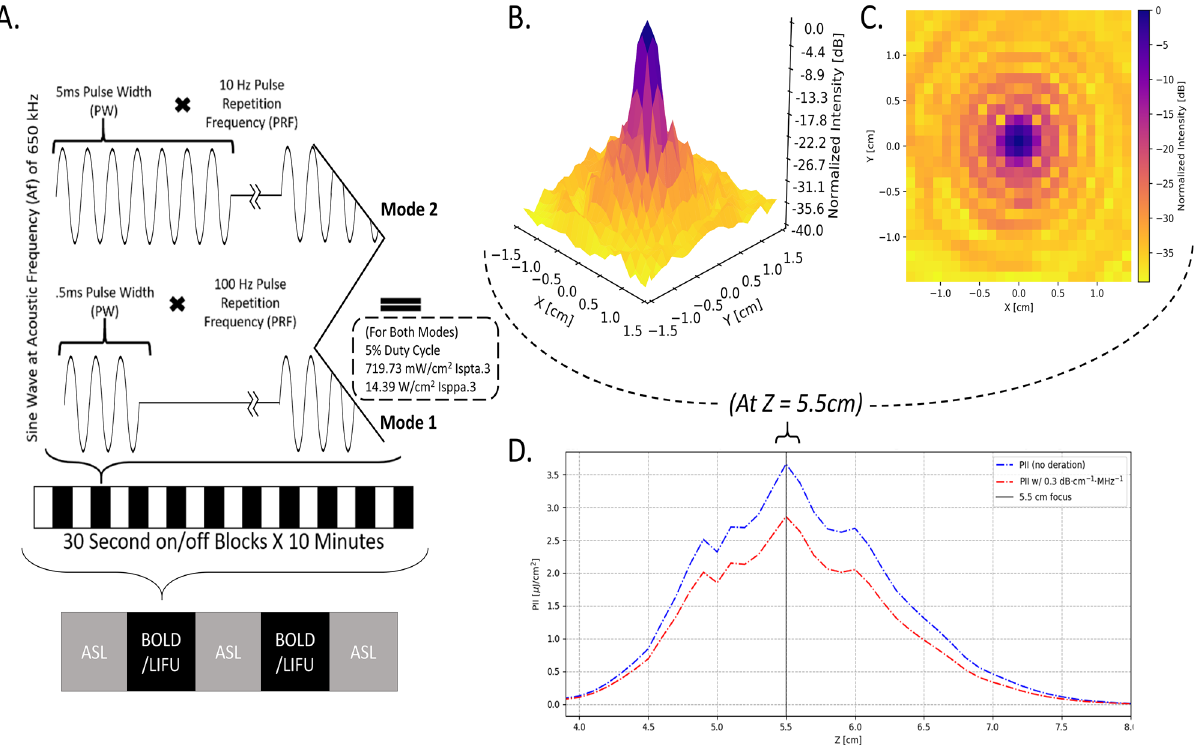
Figure 1. Sonication Parameters, Experimental Design, and Water Tank Measurements of Beam Properties. ( A ) Parameters for each LIFU mode utilized including pulsing schedule, block design, and intensity. I sppa.3 = Spatial Peak Pulse Average Intensity. I spta.3 = Spatial Peak Temporal Average Intensity; “.3” denotes deration (attenuated intensity at 0.3 dB/cm-MHz) through human tissue. Here, we have applied LIFU in two sessions, utilizing different parameter sets in each with LIFU Mode 1 having a pulse repetition frequency (PRF) of 100 Hz PRF and a pulse width (PW) of 0.5 ms PW while LIFU Mode 2 = 10 Hz PRF, 5 ms PW; all other factors including duty cycle (DC) = 5% and intensity I spta.3 (Spatial Peak Temporal Average) 42 = 720 mW/cm 2 ; I sppa.3 (Spatial Peak Pulse Average) 42 = 14.40 W/cm 2 were held constant. ( B , C ) Intensity in the radial plane (X/Y plane, extending from focal point of ultrasound beam 5.5 cm from transducer surface) shown in both 3 ( B ) and 2 ( C ) dimensions. A 50% (− 3 dB) reduction in peak intensity occurs in an area approximately 0.5 cm in width. Note that the decibel scale is nonlinear and -3 dB approximately corresponds to a 50% reduction in intensity; this scale is normalized to maximal intensity, where peak intensity equals 0 dB. ( D ) Intensity in the longitudinal plane (Z plane, extending from transducer) in absolute (pulse intensity integral (PII); “.3”denoting absorption in human tissue at 0.3 dB/cm-MHz) values of Z correspond to distance from the transducer surface. Note the peak intensity 5.5 cm from the transducer surface and that a 50% (− 3 dB) reduction in peak intensity is found in an area approximately 1.5 cm in